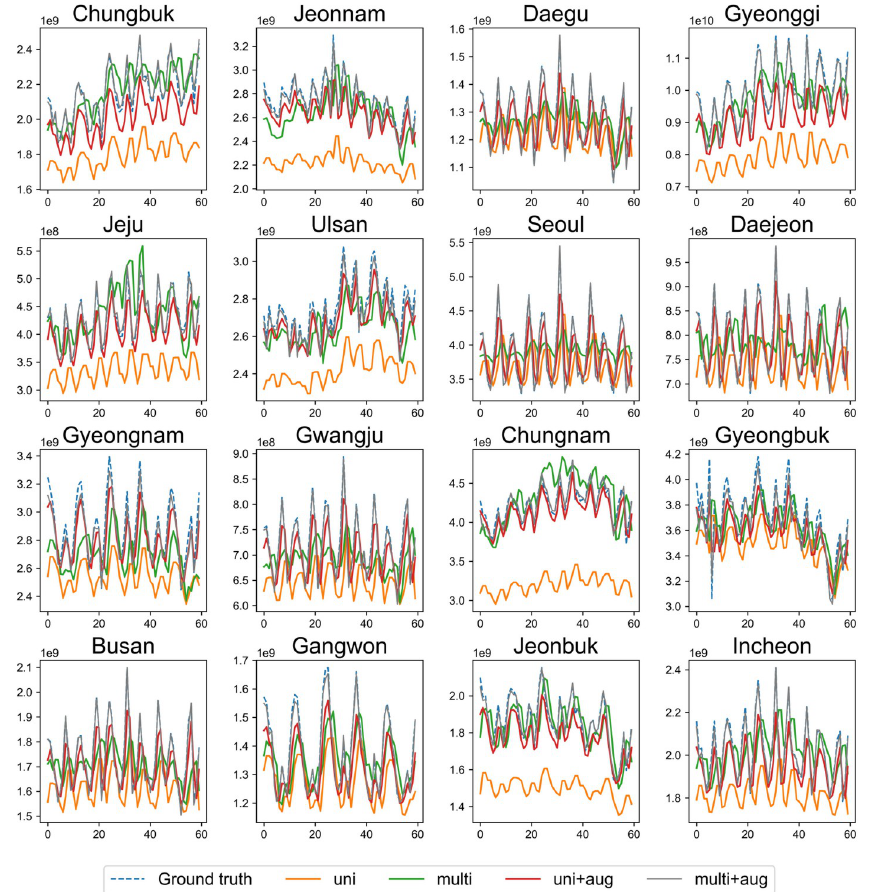
Fig 5. State-level forecasting performance comparison of